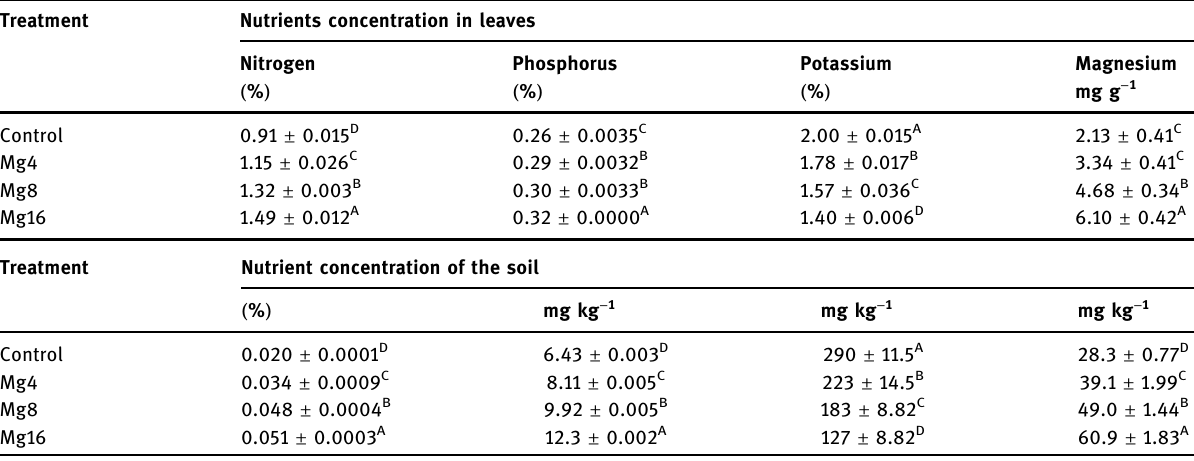
Table 4: Maize leaves and soil nutrient concentration under various levels of Mg in calcareous soils Treatment